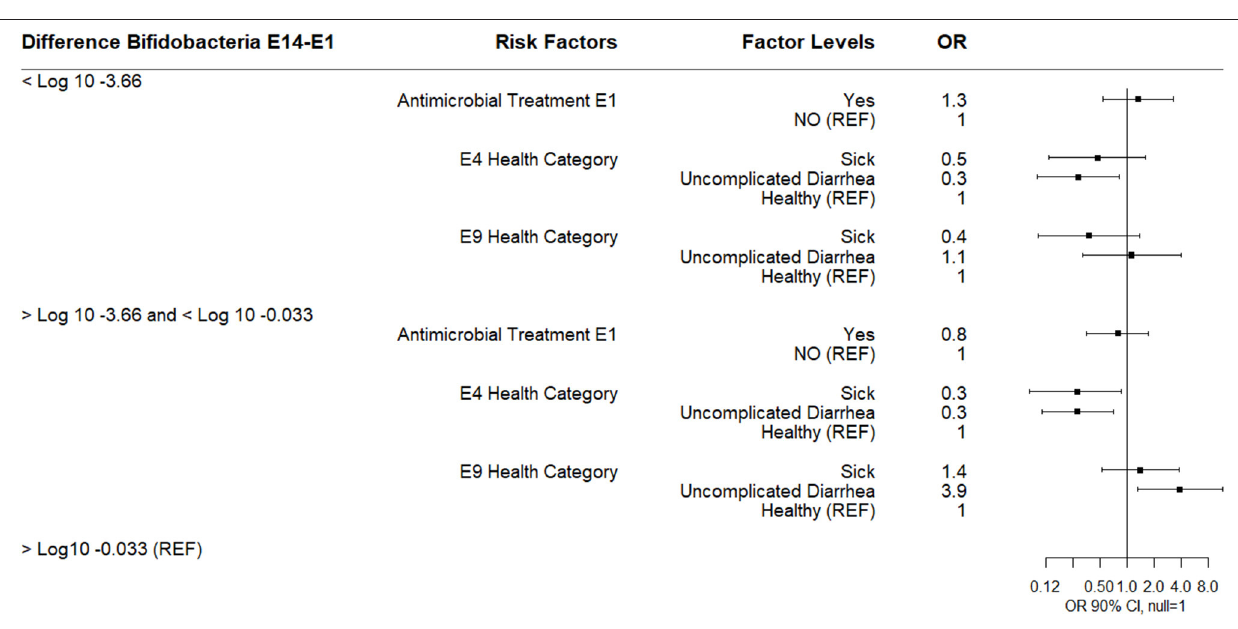
FIGURE 5 | Results of multinomial logistic regression modeling the change in Log 10 Bifidobacterium copies/gram fecal between sampling day E14 and sampling day E1. Odds ratios and 90% confidence intervals are shown. E4 and E9 health categories were defined as: sick (diarrhea with not finishing milk meal and/or depressed attitude), uncomplicated diarrhea (diarrhea with no additional clinical signs), and